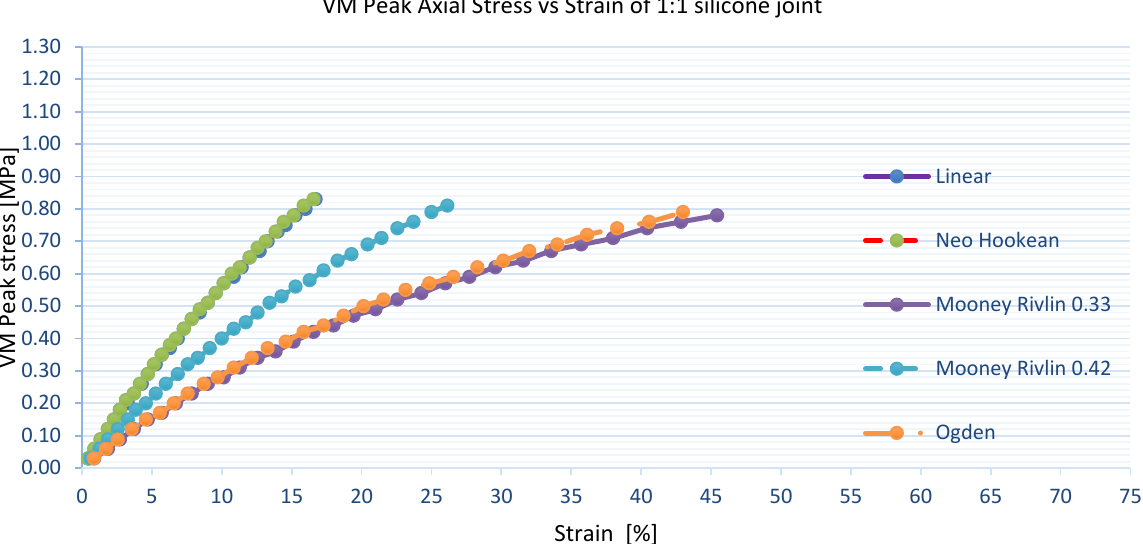
Graph 2 Material models: VM Axial stress vs strain results for 1:1 aspect ratio silicone joints.